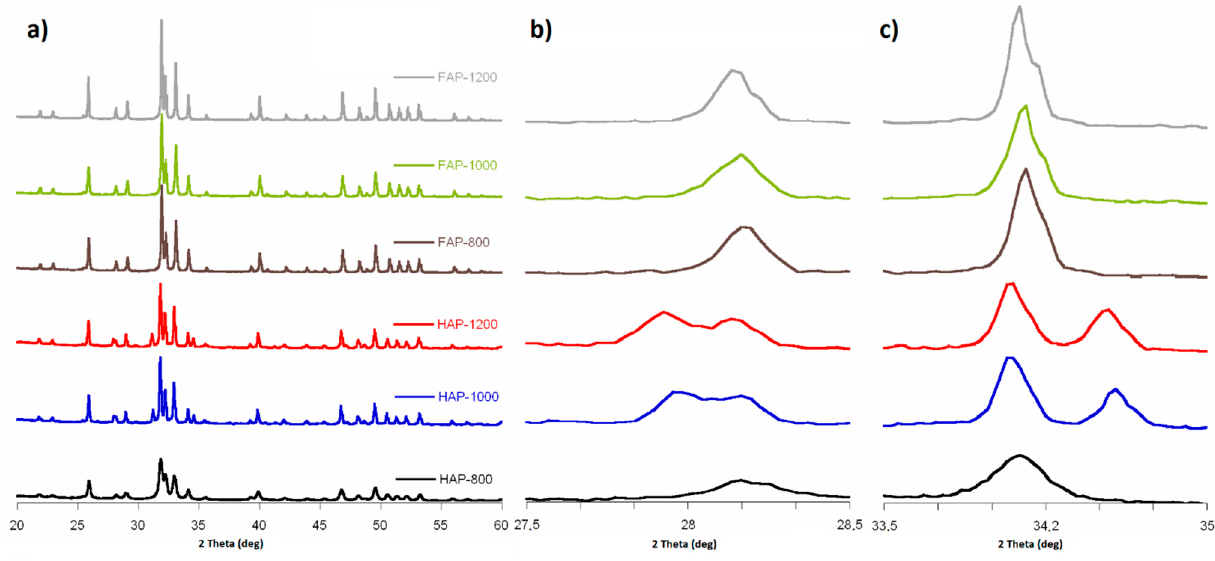
Figure 1. PXRD diffractograms: ( a ) 2 Θ range from 20 to 60 ◦ ; ( b ) 2 Θ range from 27.5 to 28.5 ◦ (magnified 5 × ); and ( c ) 2 Θ range from 33.5 to 35.0 ◦ (magnified 5 × ).